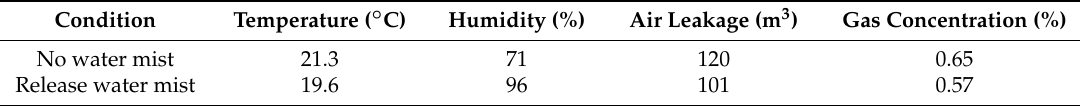
Figure 10. Prevention and control measures of gas combustion in the goaf using water mist: 1 additives, 2 high pressure pump, 3 filter screen, 4 airflow direction, 5 delivery pipeline, 6 water mist nozzle, 7 release direction, 8 main feedwater pipe, and 9 water tank. Table 1. The change of gas concentration test results on the working